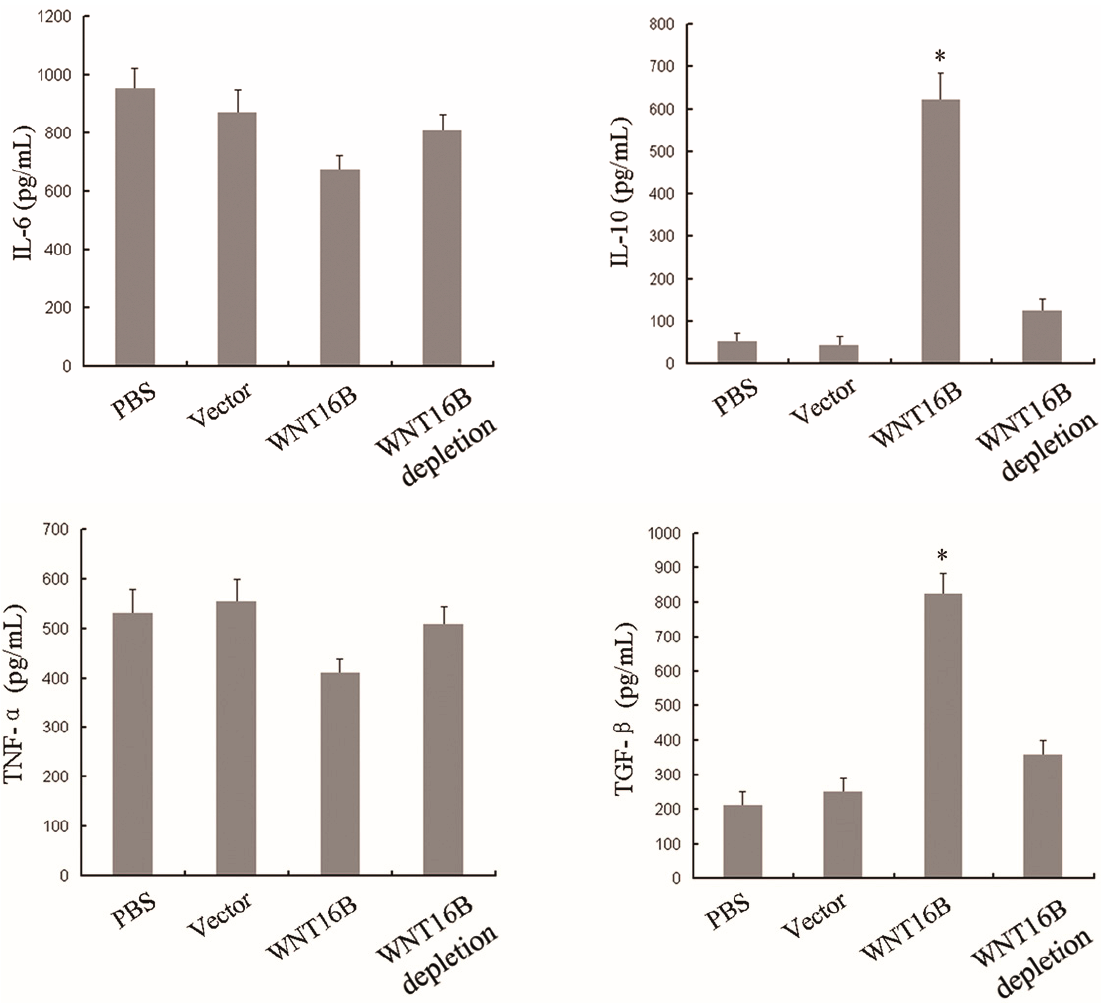
Figure 3. Different cytokine secretion occurred following WNT16B-induced DC differentiation. DCs were cultured in different conditioned medium including PBS, vector, WNT16B or WNT16B depletion, respectively for 3 days. IL-6, IL-10, TNF- α and TGF- β in cell culture supernatant were determined by ELISA (enzyme-linked immunosorbent assay). (Asterisks indicate statistically significant difference versus the vector group, p <